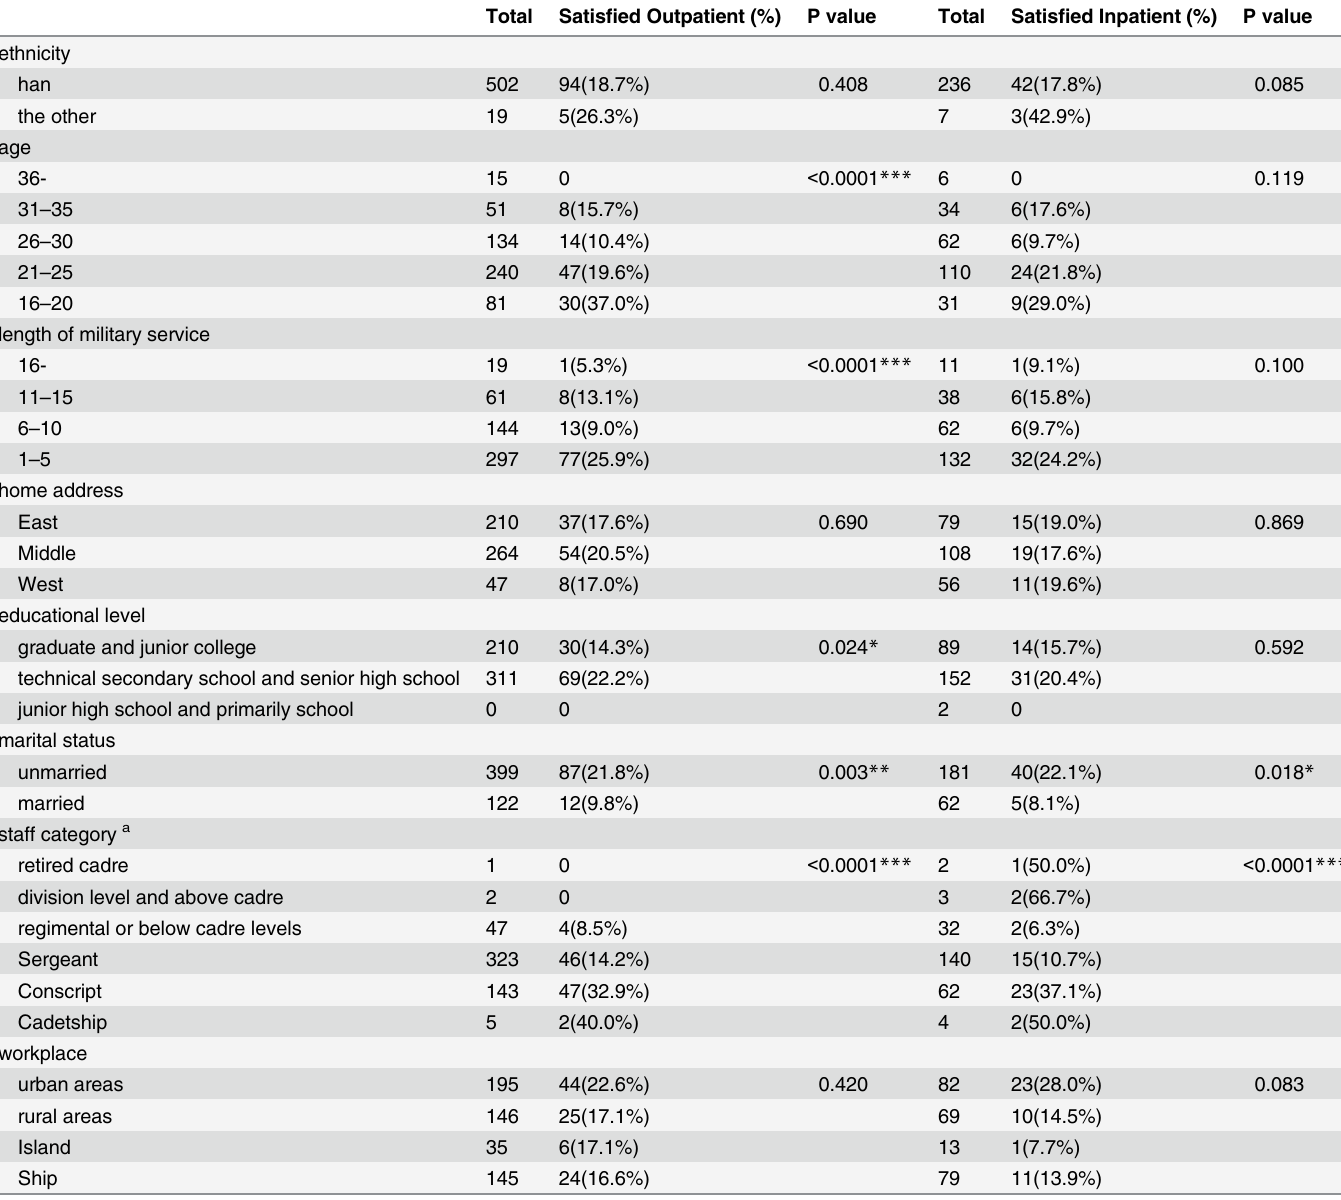
Table 1. The relationship between the overall satisfaction and soldiers demographic characteristic of the outpatient and